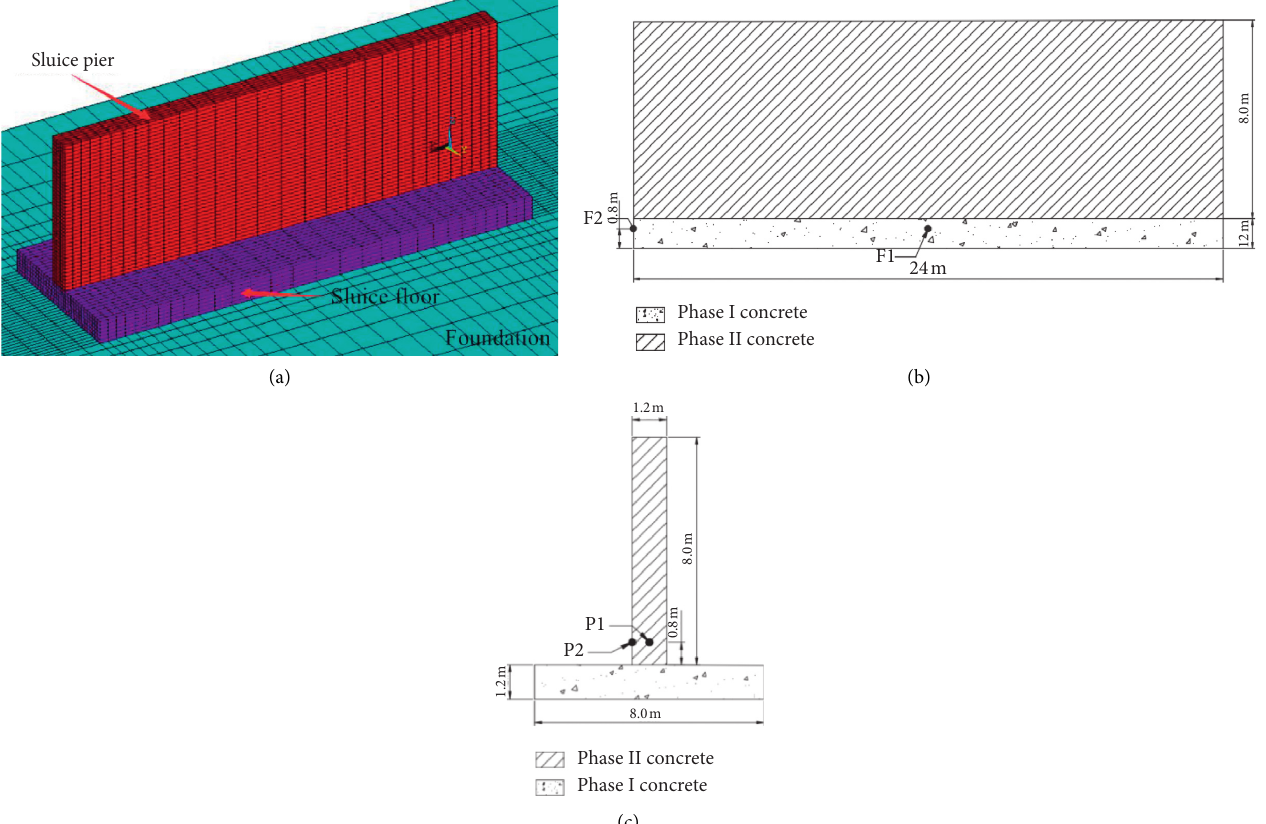
Figure 8: The finite element model, structure size, and key points of the